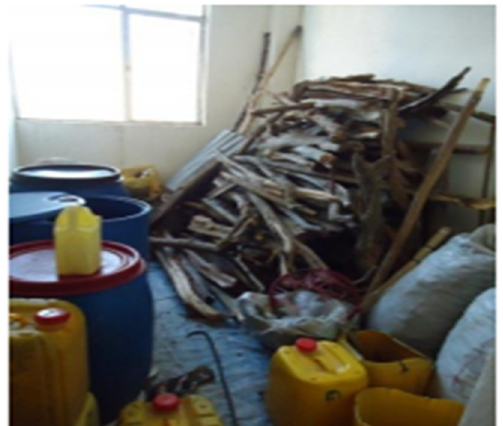
Figure 17. Bedroom used for storage in a condominium house .